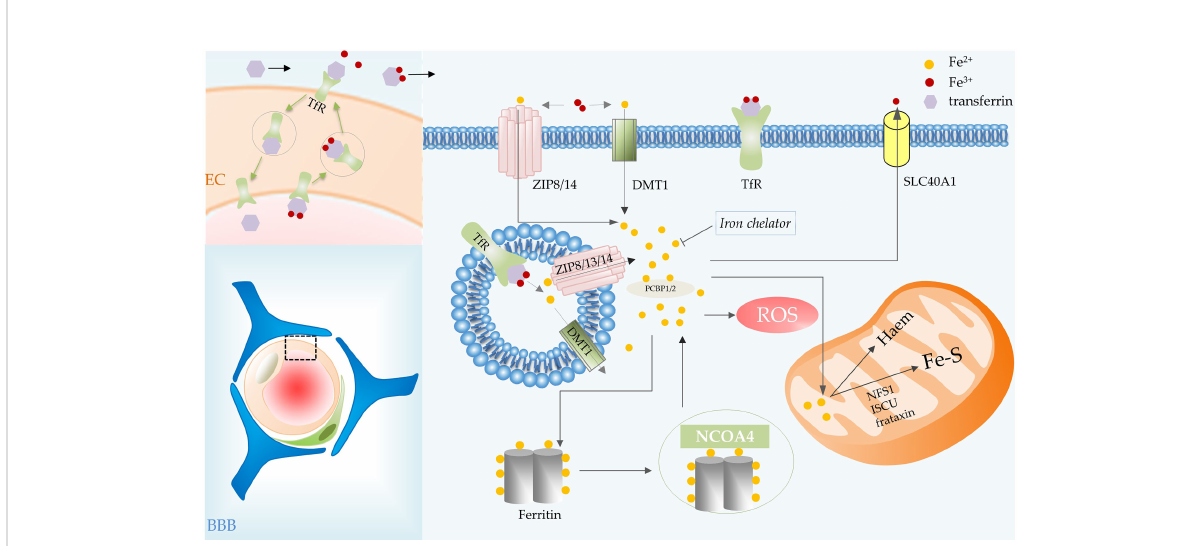
FIGURE 2 Iron metabolic processes involved in ferroptosis in glioma. BBB consists of ECs, basement membrane, pericytes, and astrocytic end feet. Iron transport depends on the TfR of vascular ECs in the BBB. Transferrin carries iron, the transferrin-receptor complex is internalized and then transported to the abluminal side of the endothelium. Transferrin combines with most of the iron that crosses the BBB, iron is then delivered to cells. In the cell, iron is released from transferrin in acidic endosomes. Endosomal iron can be delivered to the cytoplasm via DMT1, ZIP8, ZIP13 and ZIP14. Intracellular iron can be transported out of cells by SLC40A1, utilized by mitochondria for the synthesis of heme and Fe-S, and stored in ferritin. The iron in ferritin can be released by NCOA4-mediated ferritinophagy. Abbreviations: BBB, blood brain barrier; EC, endothelial cell; TfR, transferrin receptor; SLC40A1, solute carrier family 40 member 1; NCOA4, nuclear receptor coactivator